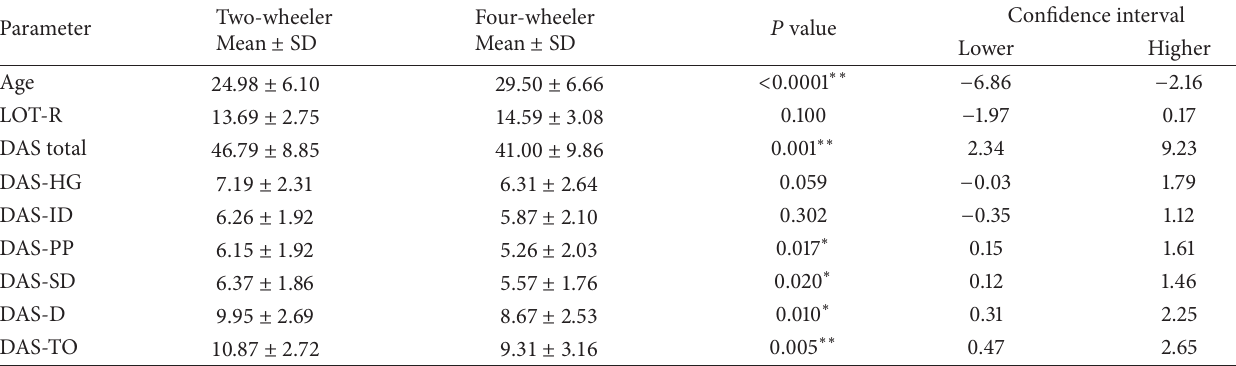
Table 4: Group comparison on basis of driving vehicle [ two-wheeler ( 𝑛 = 62 ) and four-wheeler ( 𝑛 = 54 ) ] .